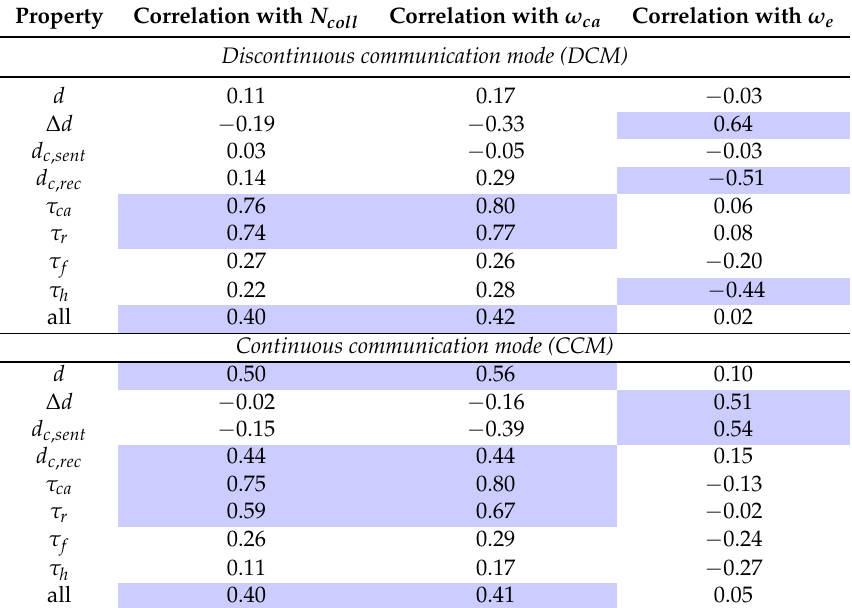
Table 5. Correlation coefficients quantifying correlations of ρ q with N coll , ω ca or ω e . Property Correlation with N coll Correlation with ω ca Correlation with ω e Discontinuous communication mode (DCM)